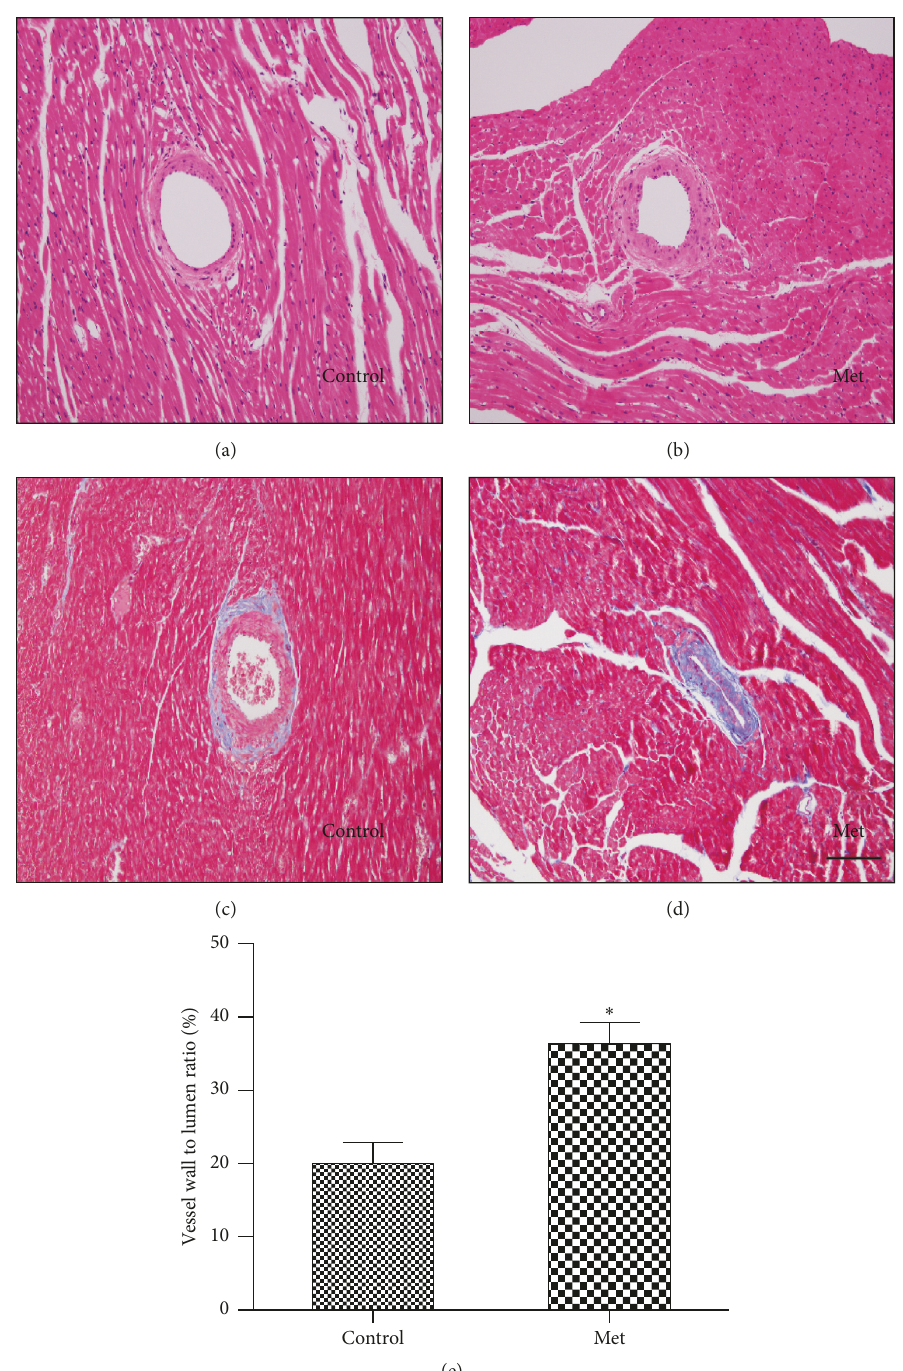
Figure 4: Representative images of stained heart sections. H&E stained sections from the control-diet group (a) and the Met-diet group (b) showed hyperhomocysteinemia induced coronary arteriolar wall thickening. Masson’s trichrome staining showed hyperhomocysteinemia induced collagen accumulation in coronary arterioles in the Met-diet group (d) compared with vessels from the control-diet group (c). The wall-to-lumen ratios of coronary arterioles in the Met-diet group were increased compared with the control-diet group ( ∗ 𝑝 < 0.05 ) (e). Original magnification was × 100 for (a)–(d) and the scale bar = 100um. Values are mean ±